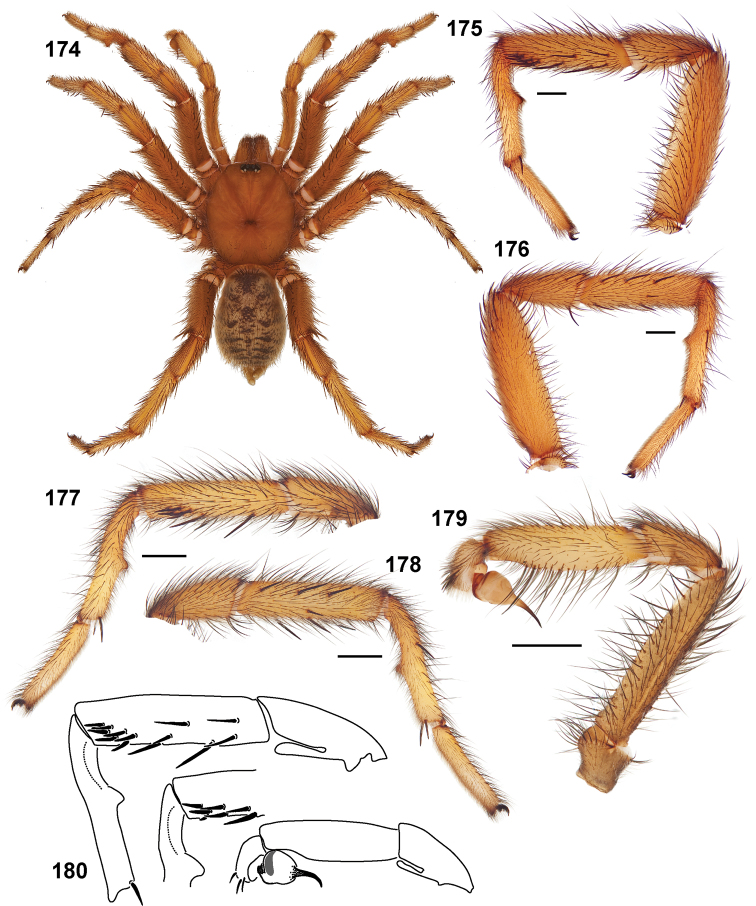
Aptostichus barackobamai sp. n. 174–176 male holotype from Mendocino Co. (AP411) 174 habitus [806630] 175 retrolateral aspect, leg I [806634] 176 prolateral aspect, leg I [806636] 177–179 male paratype from Tehama Co. (MY3805) 177 retrolateral aspect, leg I [806638] 178 prolateral aspect, leg I [806642] 179 retrolateral aspect, pedipalp [806644] 180 line drawings of leg I holotype and paratype specimens; retrolateral aspect of holotype pedipalp. Scale bars = 1.0mm.